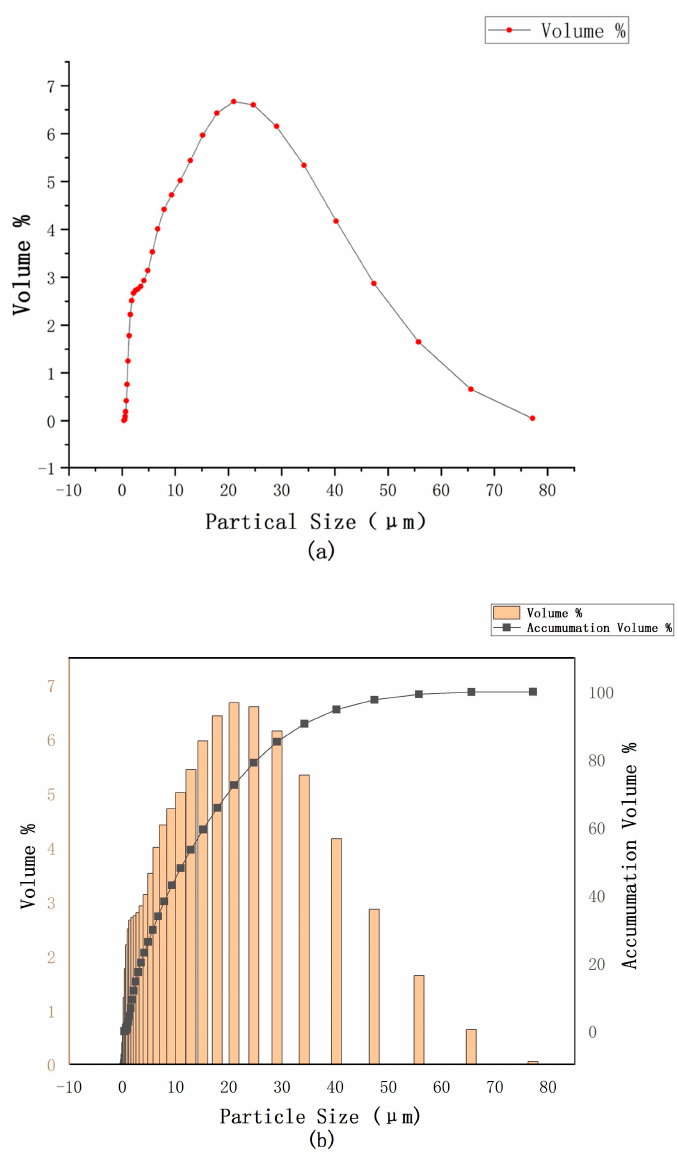
Figure 1. ( a ) Volume of the particle size; ( b ) cumulative proportions of the particle size.